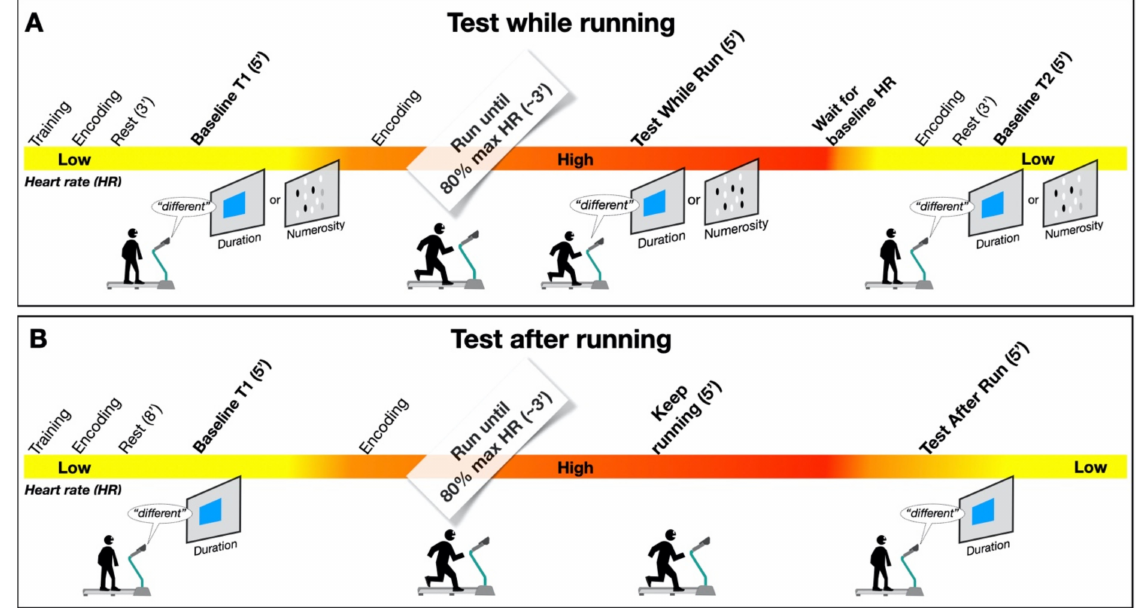
Figure 1. Experimental procedure. ( A ) Paradigm used to measure duration and numerosity percep- tion while running. After a short training session, participants were presented with the reference stimulus (encoding phase: 600 ms or 24 dots) 5 times. After a rest period of 3 min, they were presented with a sequence of test stimuli to categorize as same or different, compared to the reference (baseline T1). After the task, the encoding was repeated, followed by the running phase. During the first three minutes of running, no stimuli were presented; then, the same different task (duration or numerosity) was performed, this time while participants kept running. After this test phase, participants were allowed to rest until the heart rate returned to the baseline level. At this point, a second baseline (T2) was measured. After a short break, the whole procedure was repeated. ( B ) Paradigm used to measure duration perception after running. This was similar to that described above ( A ) except the rest period before baseline measurement (T1) was 8 min instead of 3 min, and the test measurements were made after the participant stopped running while the heartrate reverted to